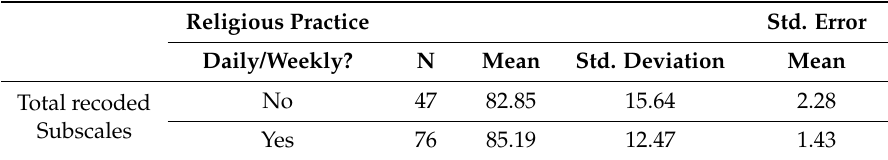
Table 6. Religiosity and Total IRMA Score: Independent Samples T-Test.